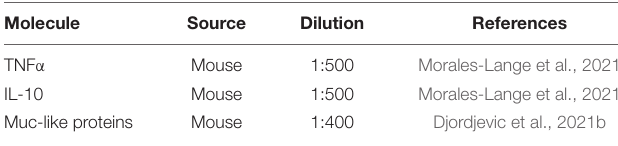
TABLE 3 | Primary antibodies for indirect enzyme-linked immunosorbent assay